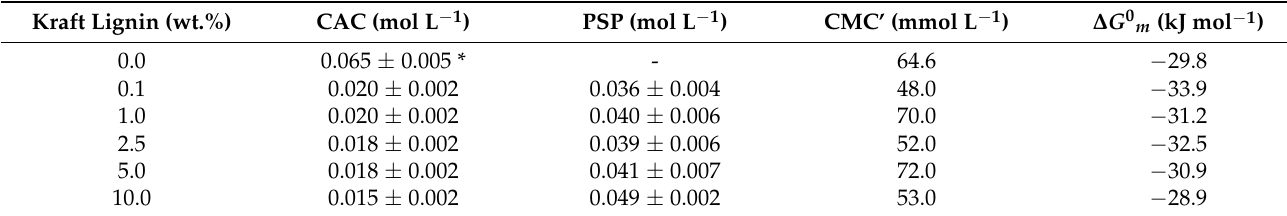
Table 1. The CMC, CAC, and PSP of DeTAB for different initial concentrations of lignin obtained from the conductivity data at 25 ◦